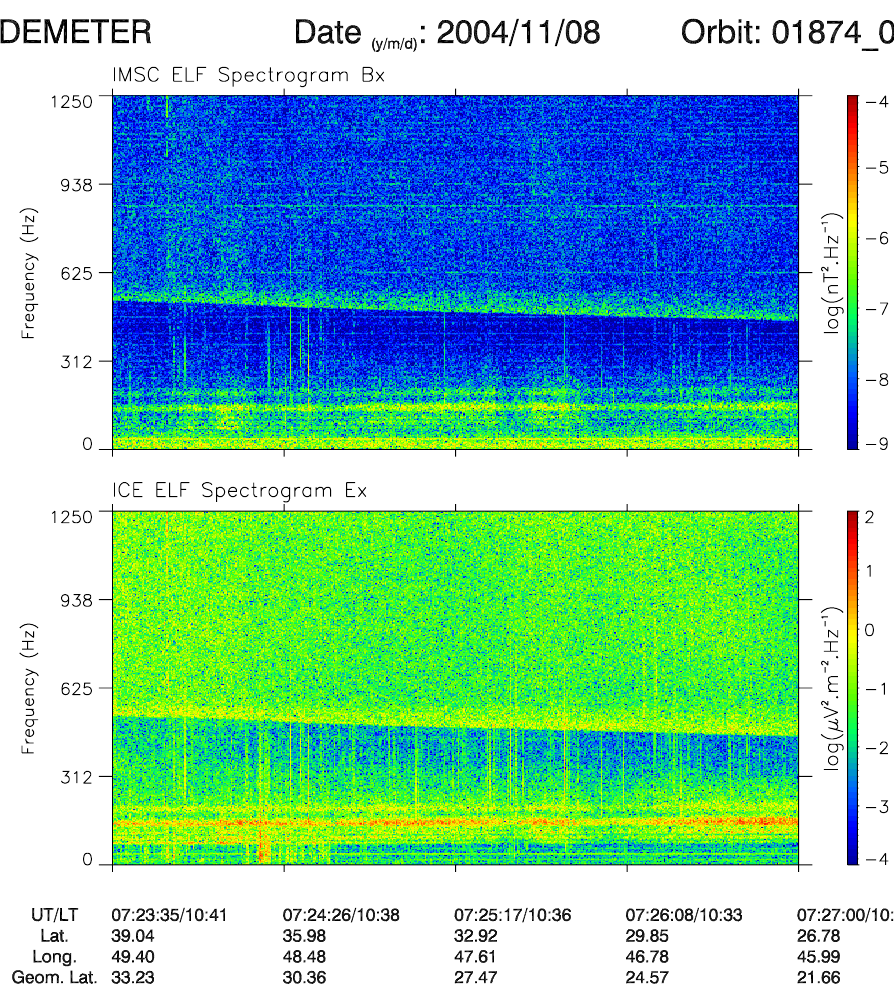
Fig. 3. Similar to Fig. 1 but recorded on 8 November 2004 (event